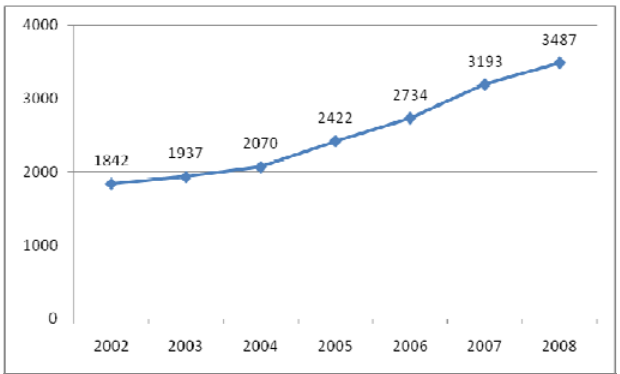
Figure 1 . Evolution in the number of papers with the keyword “phenolics” (Scopus, June